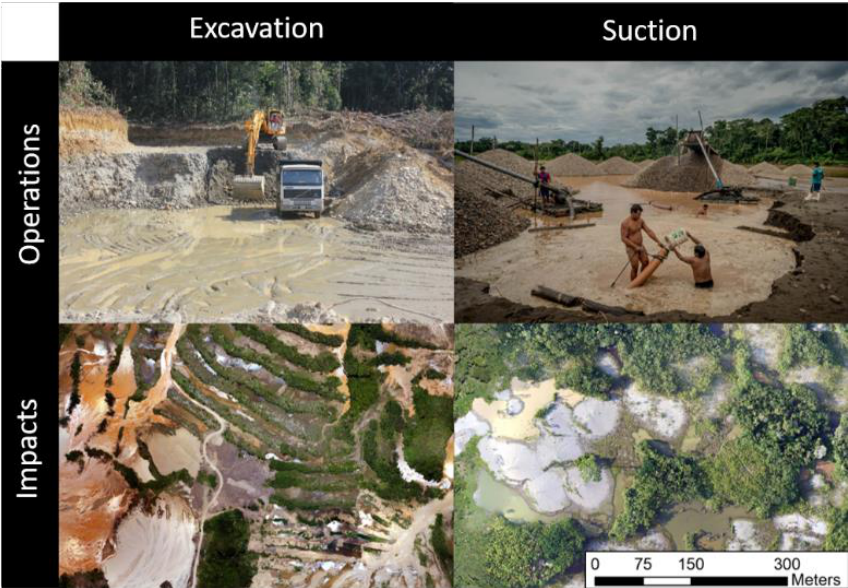
Figure 3. Operations and impacts (rows) according to the type of gold mining in Madre de Dios. Operations can be classified broadly by whether sediment is moved by excavation using heavy machinery ( left ) or through liquefaction with water cannons and suction pumping ( right ). Impacts on landscape from the two types of ASGM-caused land conversion are distinct and are shown in the bottom row. Aerial imagery taken by unmanned aircraft on 8 October 2017 and 6 October 2017 for excavation and suction mining, respectively.